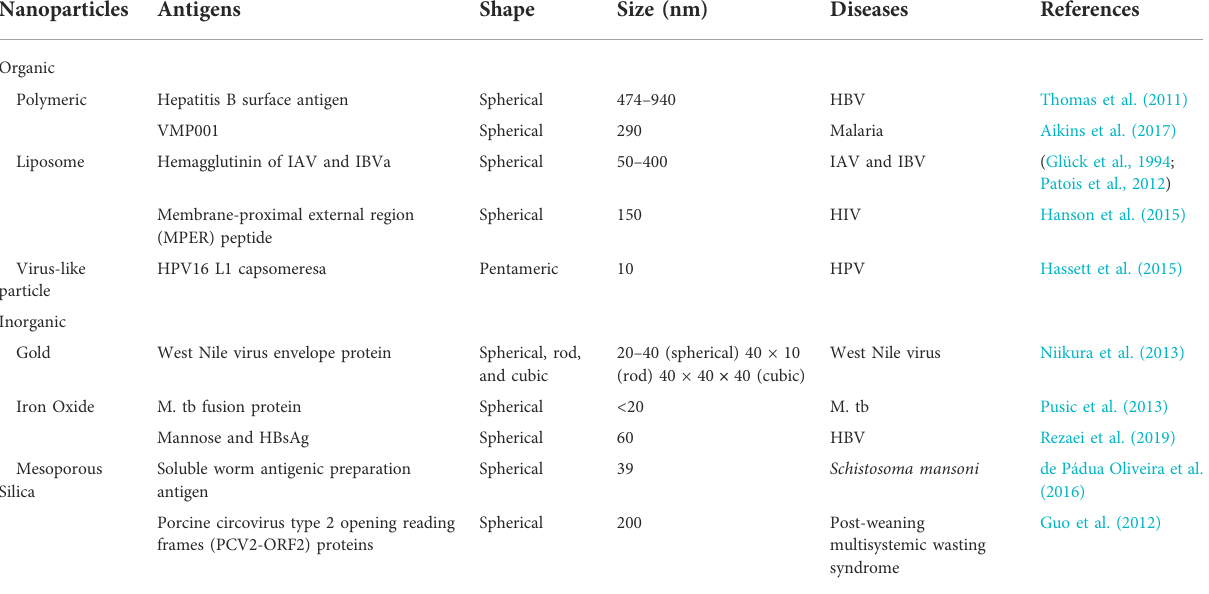
TABLE 1 Organic and inorganic vaccine nanoparticles against infectious